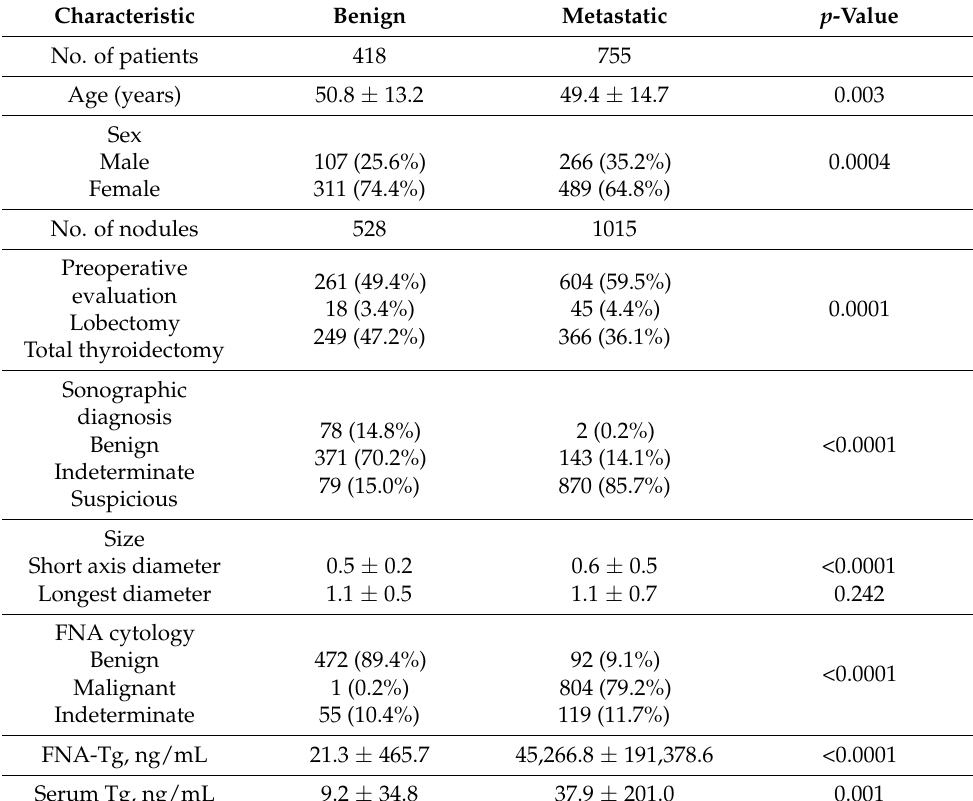
Table 1. Demographic and clinical characteristics of patients and lymph